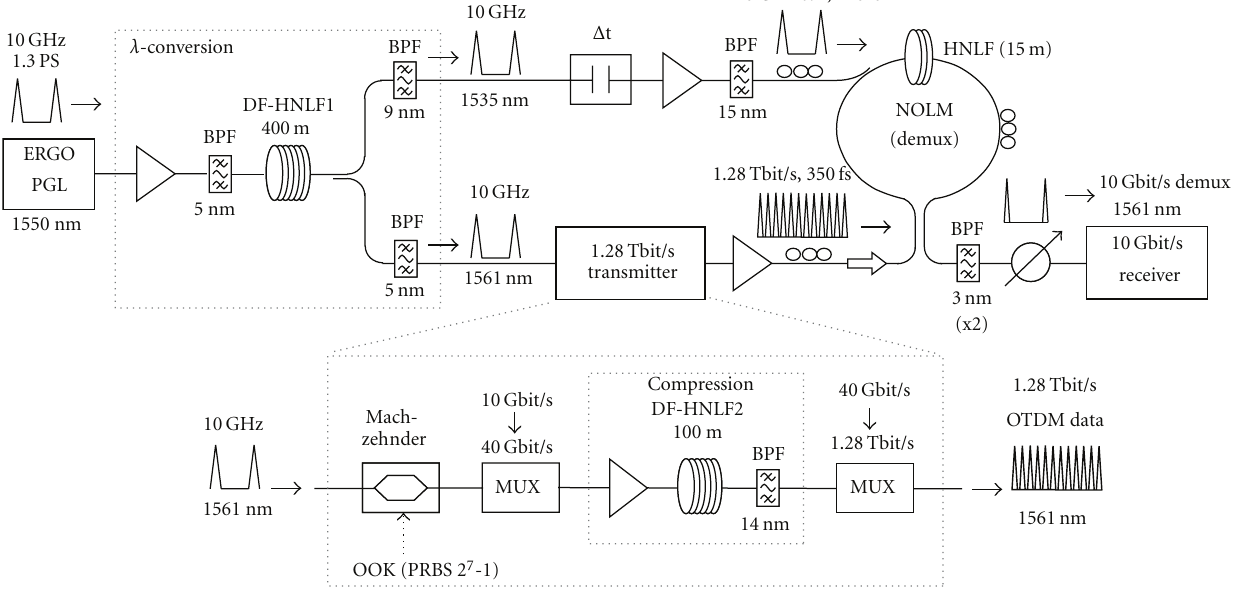
FWHM is obtained at the input to the HNLF in the